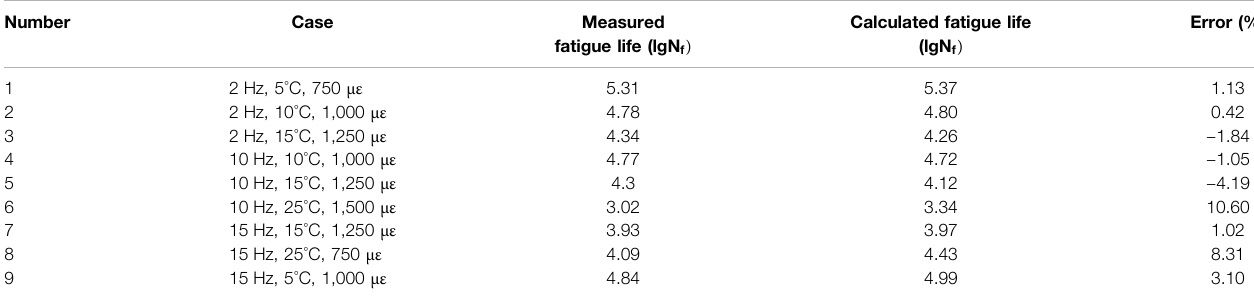
TABLE 8 | Comparison between the measured and predicted values of fatigue life.